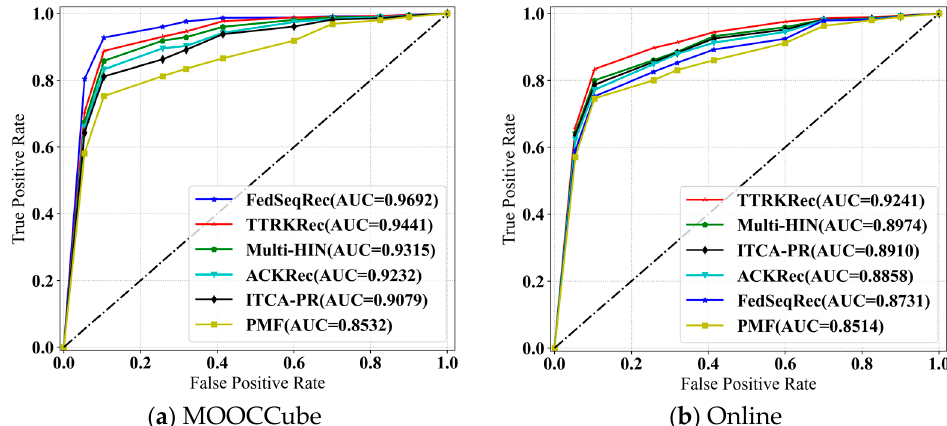
Figure 7. Comparison of the ROC curves of all models on MOOCCube and Online datasets.